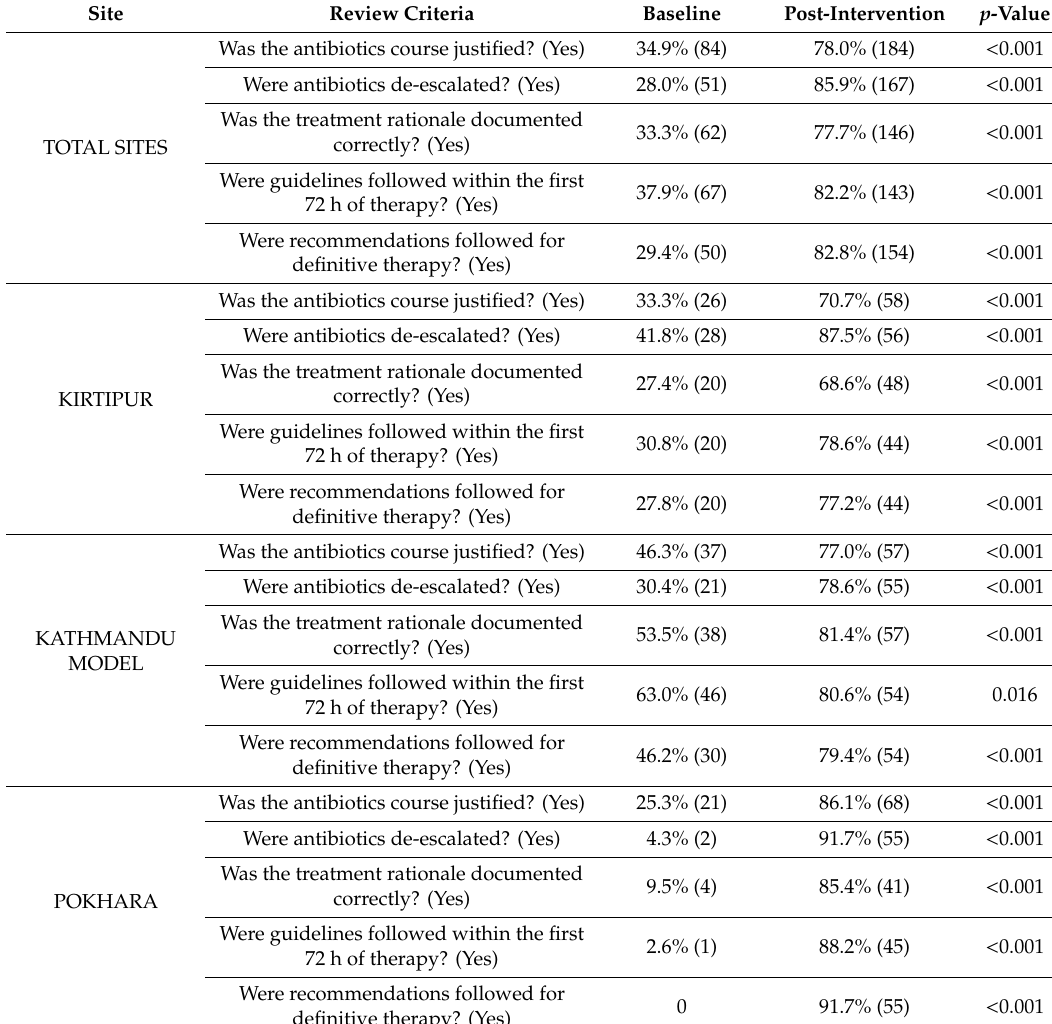
Table 3. Justification, de-escalation, treatment rationale, and fidelity to guidelines at baseline and post-intervention by total sites and individual hospitals (Kirtipur, Kathmandu Model, and